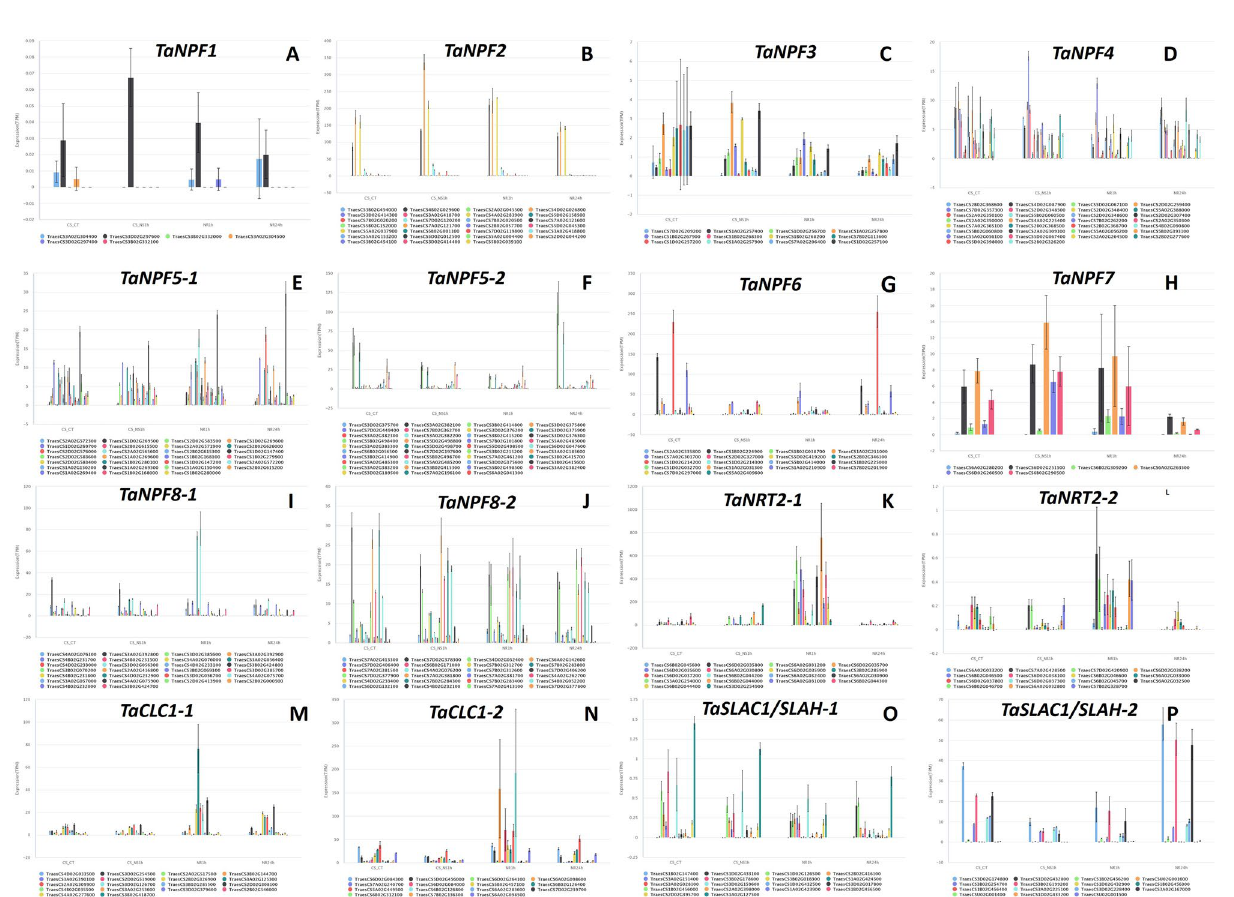
Table 4. Proximity of nitrogen use efficiency (NUE) linked SNPs 43 to nitrate transporters detected in present study.